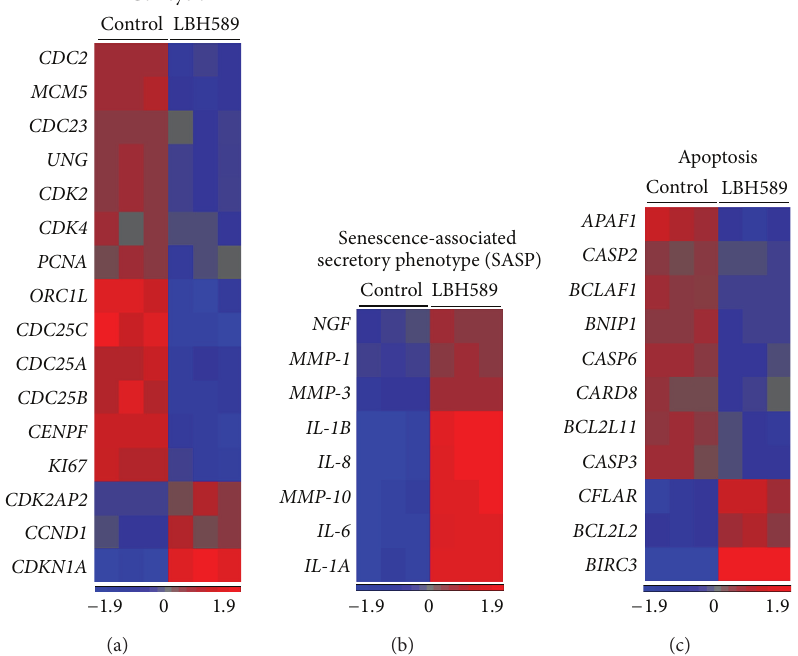
Figure 3: Low-dose LBH589 treatment induces cell cycle arrest and senescence. Heatmap representation of differentially expressed genes enriched in functional groups associated with (a) cell cycle regulation, (b) senescence-associated secretory phenotype, and (c) apoptosis. Each column represents a distinct